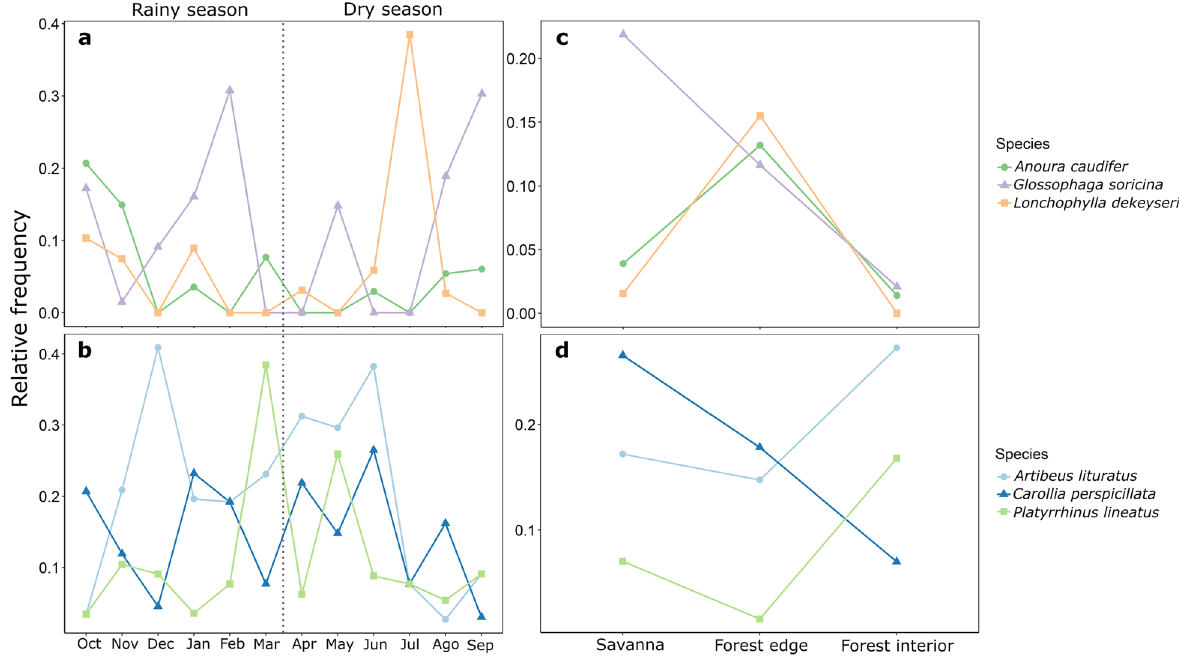
Figure 1. Spatiotemporal trends of bat capture rates of the most frequent floral visitors in the study site. Temporal trends in the relative frequency (in relation to all captured in a given month) of specialized nectarivorous bats ( a ) and mainly frugivorous bats ( b ) throughout the year. A dashed line separates the dry and rainy seasons. Spatial trends in the relative frequency of nectarivorous ( c ) and frugivorous bats ( d ) according to habitat